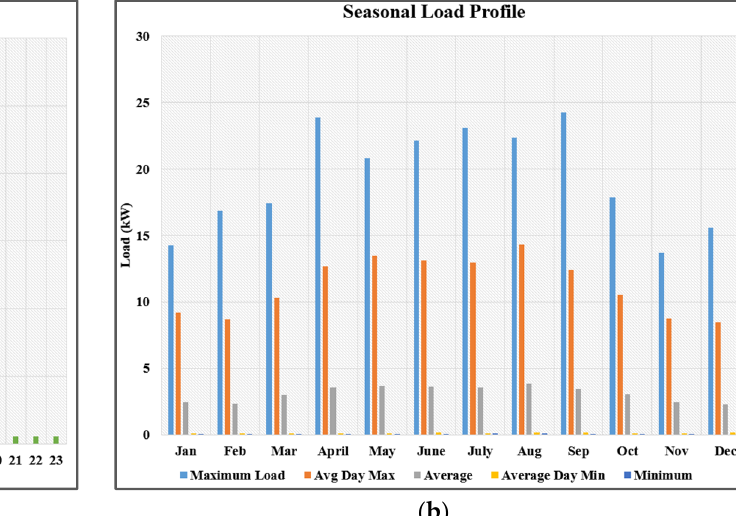
Figure 3. Complete schematic of proposed nZEB.